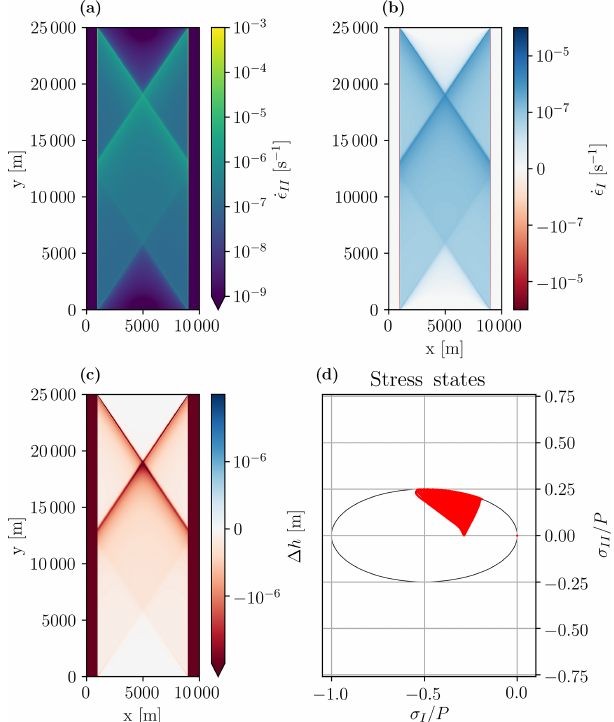
Figure 3. (a) First and (b) second strain invariants, (c) ice thickness anomaly ( (cid:49)h = h − 1), and (d) stress states in normalized stress in- variant space along with the elliptical yield curve after 5s of integra- tion. The first and second strain invariants represent the divergence and maximum shear strain rate, respectively. The modeled angle of fracture is θ = ( 34 ± 1 ) ◦